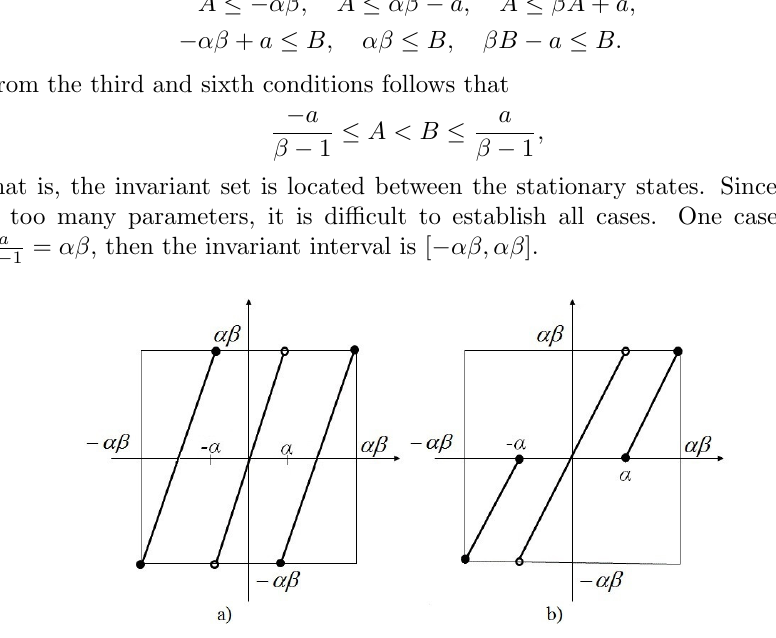
Figure 10. [ − αβ,αβ ] is invariant set of function h . a) a = 2 αβ b) a = αβ